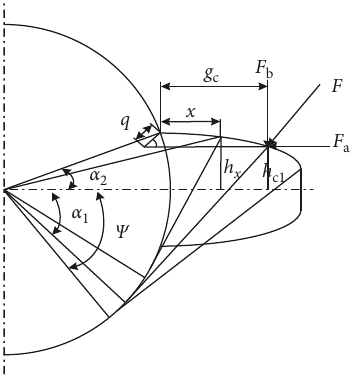
Figure 2: Force diagram of gear mesh. Table 4: Values of the coefficients of equation